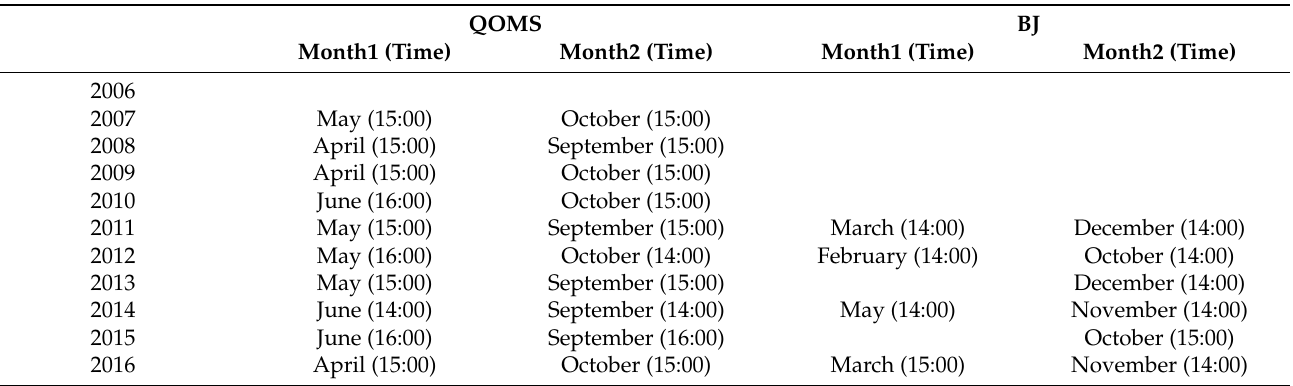
Table 2. The month and the specific timing of the occurrence of the two large centers in SH diurnal variation at six stations from 2006 to